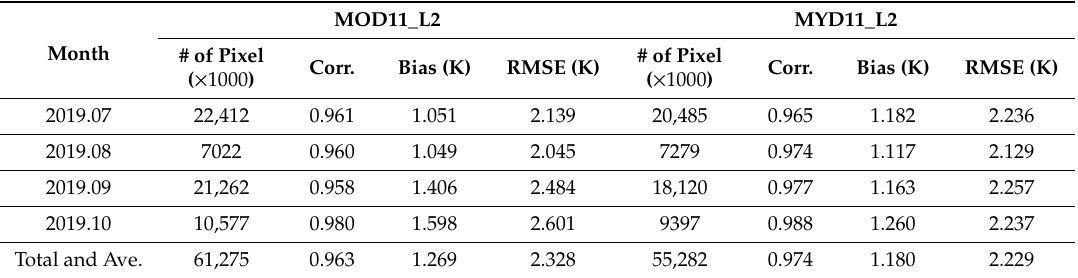
Table 4. Comparison results of the GK2A LST data and the MODIS LST product (Collection 6) for the selected four months (July, August, September, and October 2019).